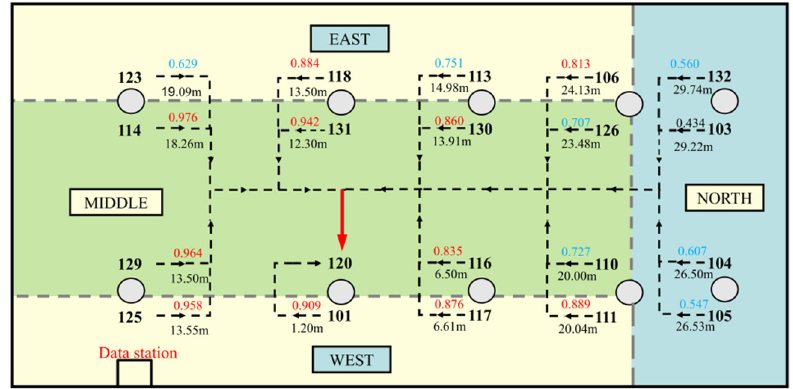
Figure 4. The correlation coefficients of sensor node No.120 with other sensor nodes.